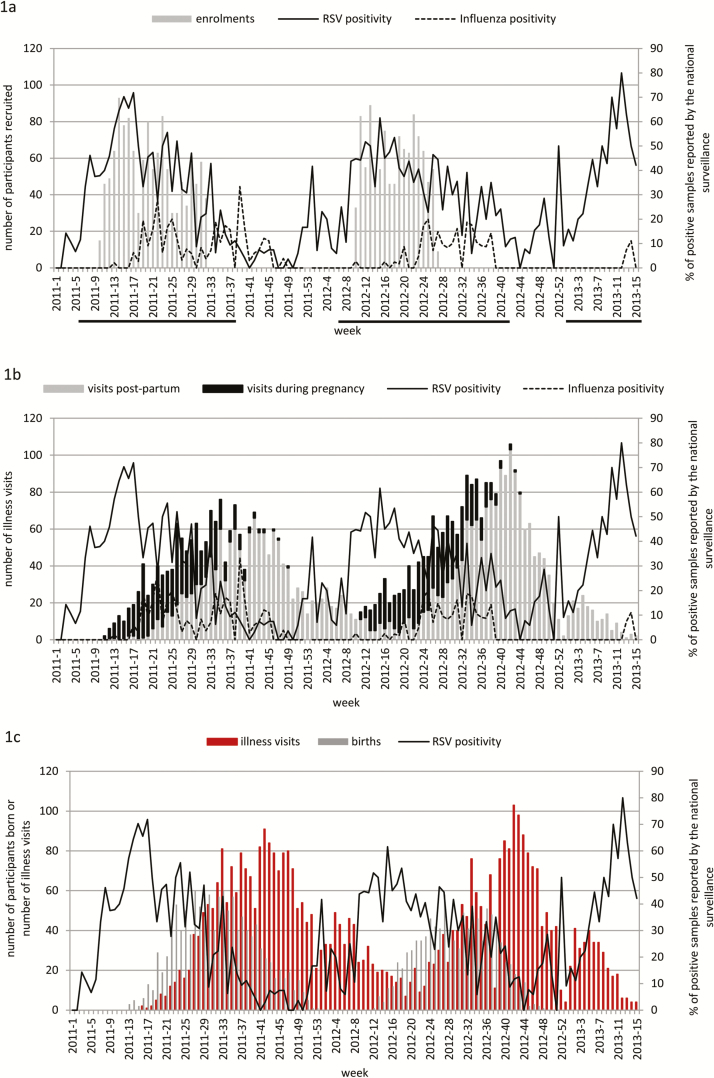
Number of participants in the study by week and respiratory syncytial virus (RSV) and influenza seasonality. RSV and influenza positivity rate were calculated using data from the South Africa national surveillance system. Underlined are the weeks considered part of the RSV season. A, Enrollment of pregnant women into the study. B, Maternal study illness visits during pregnancy and postpartum. C, Infants born from mothers in the study and infant study illness visits.